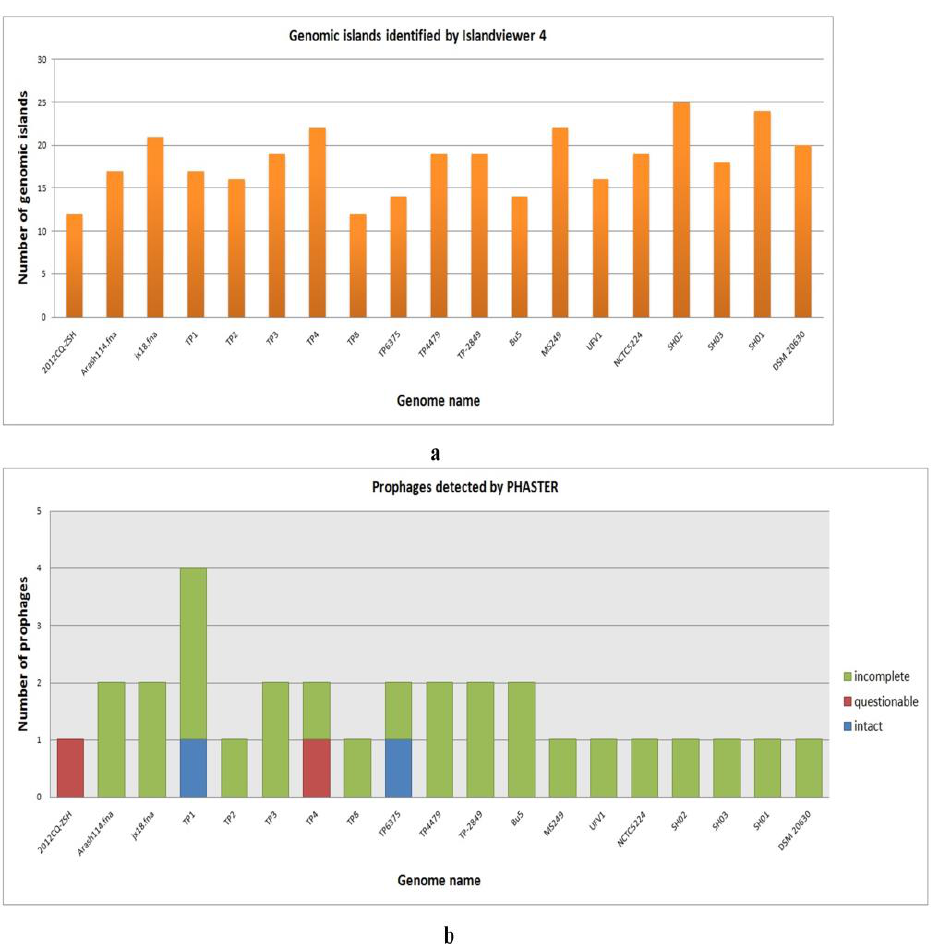
Figure 9. ( a ) Prevalence of genomic islands (GIs) in the investigated 19 T. pyogenes genomesas detected by Islandviewer4.The strains harbored GIs in the range of 12–25 with the maximum observed in strain SH01; ( b ) number of prophages detected by PHASTER in the investigated 19 T. pyogenes strains. The identified prophages were further classified into intact, incomplete, and questionable categories as depicted by blue, green, and red colors, respectively. Prophages were harbored in the range of 1–4 in the investigated strains with maximum prophages being observed in T. pyogenes strain TP1.